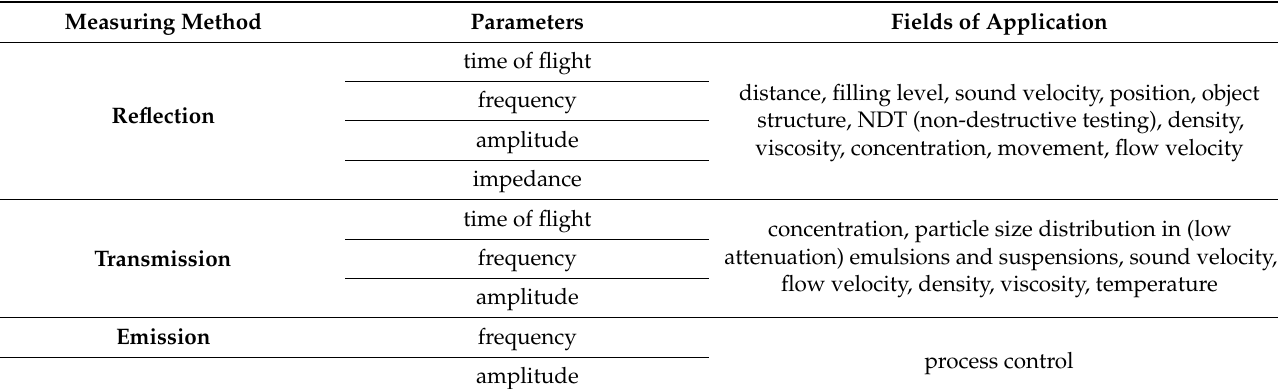
Table 1. Ultrasound-based measuring methods, utilised parameters and typical fields of